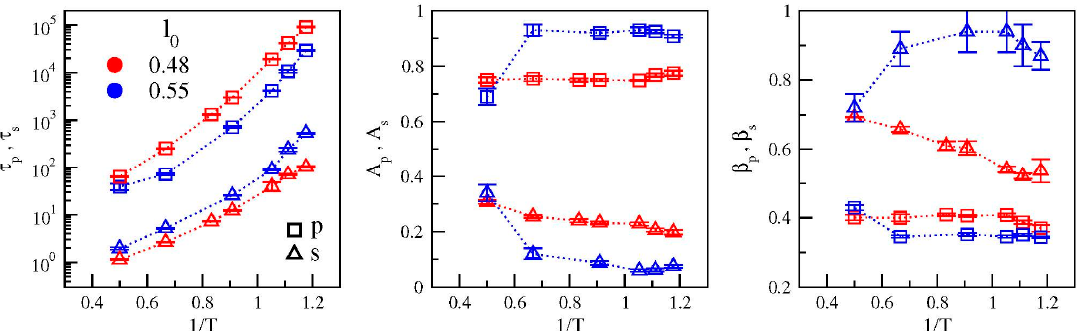
Figure 4. Plots of the temperature dependence of the best-fit parameters by using Equation (5) and Equation (6) (color codes as in Figure 1). From left to right: apparent relaxation times, relaxation strengths and stretching exponents.